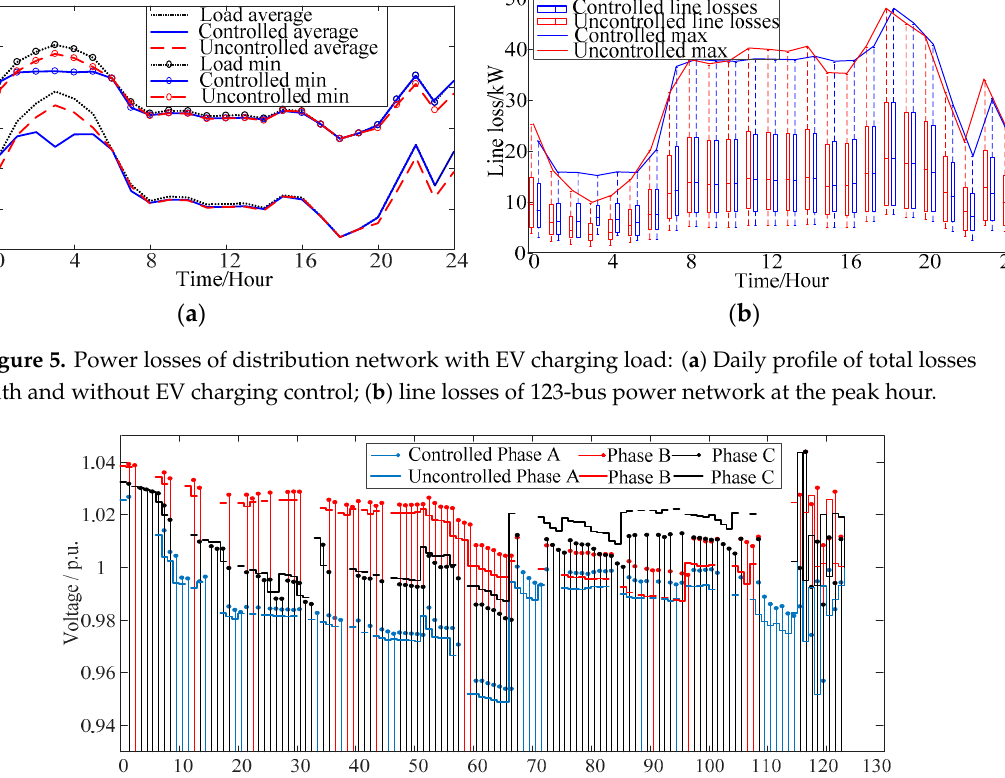
Figure 6. Bus voltage of the 123-bus test system with and without EV charging control.